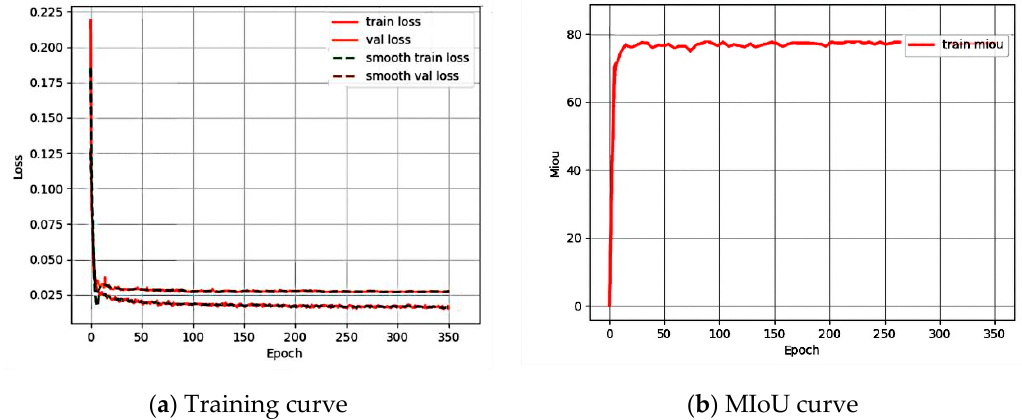
Figure 13. Training curve and MIoU curve of PSPNet model.